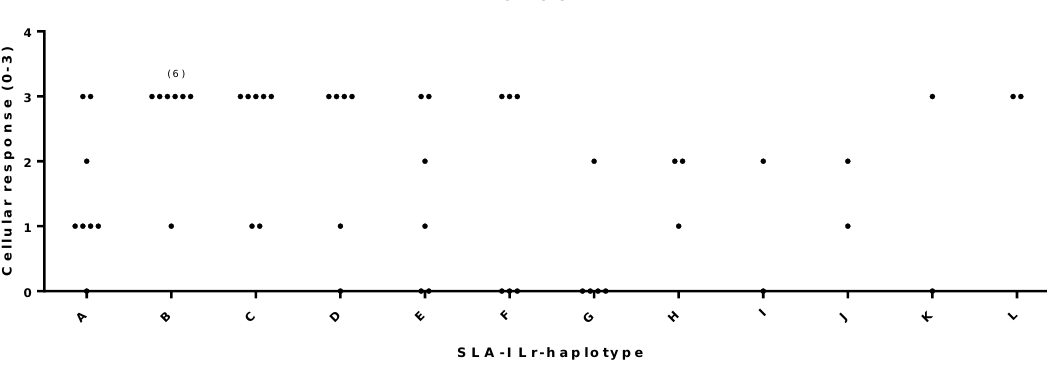
Figure 4. Significant correlation between SLA-I Low-resolution (Lr) haplotype and cellular response in pigs from group 1. Animal group composition as in Table S3, cellular response values as in Table S2 and Figure S1. Significance: χ 2 α = 0.021 *, LR χ 2 α = 0.039 *, Fisher’s exact α = 0.011 *, Cv = 0.64. IFN- γ secreting T cell values were categorized as: 0: < 50; 1: > 50 and < 90; 2: > 90 and < 140; 3: > 140. Vaccines 2020 , 8 , x FOR PEER REVIEW